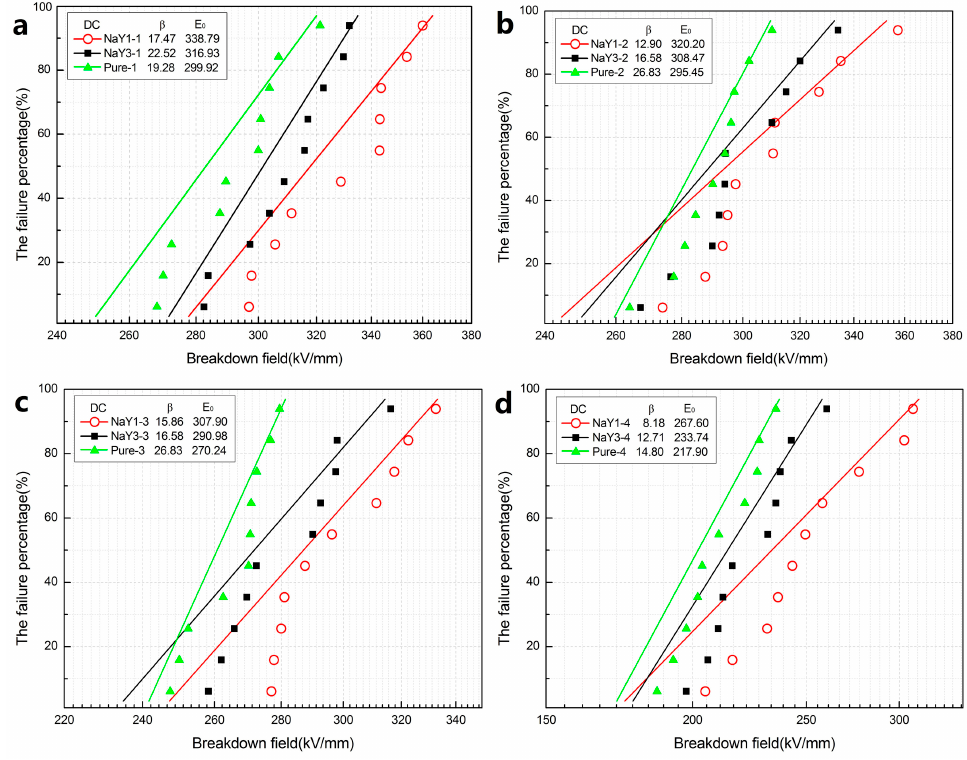
Figure 3. Weibull probability plots for direct current ( DC ) breakdown strengths of pure LDPE and zeolite / LDPE nanocomposites at 1 ( a ), 2 ( b ), 3 ( c ) and 4 ( d ) aging cycles.